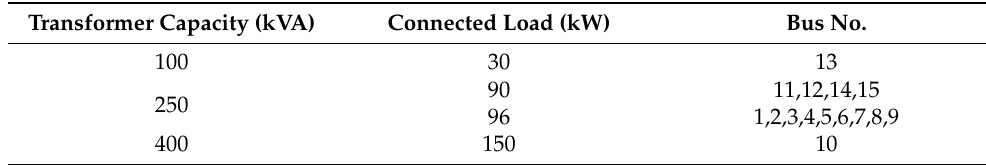
Figure 10. Simulation of the real feeder. Table 1. The parameters of the study network. Table 2. Distribution of the load for the case study. Parameters Transformer Capacity (kVA) Connected Load (kW)